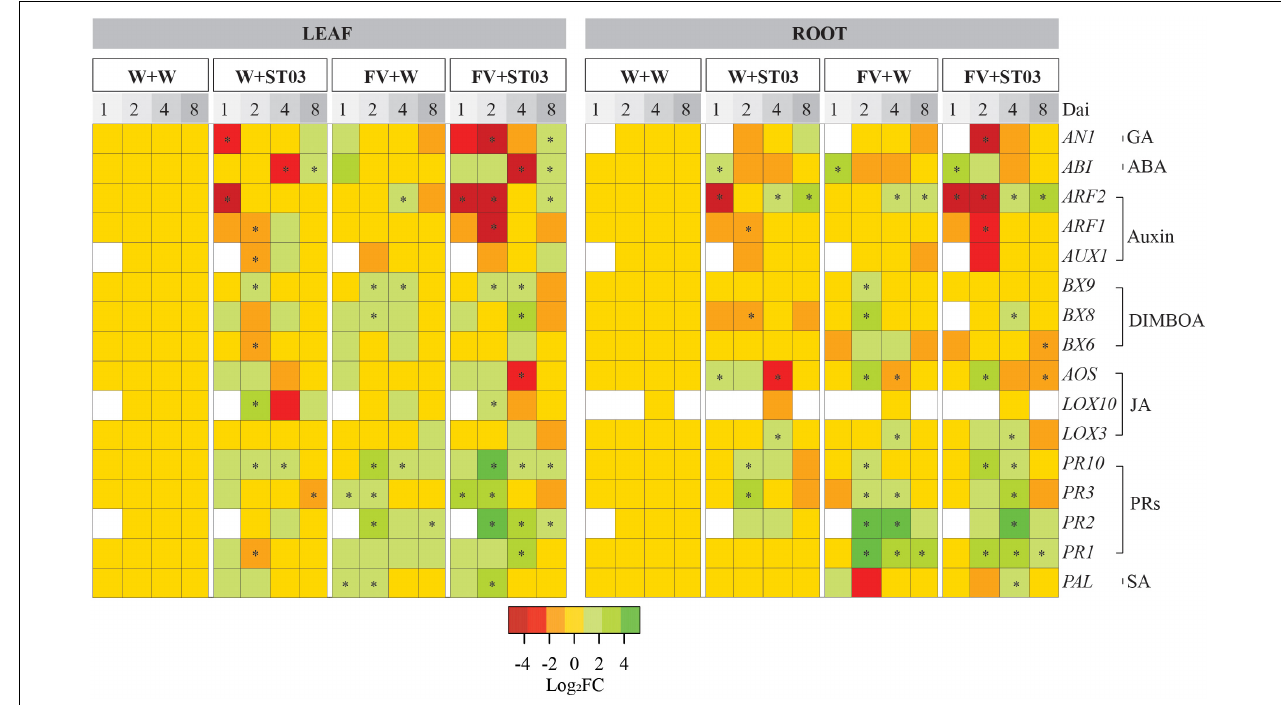
FIGURE 7 | Heat map of the differential gene expression levels in leaf and root by treatments at four-time points. This work applied Bt/GT NK7328-maize line. The colors indicate the FC changes (FC) of gene expression in log base 2. Up-regulation of each gene is shown in green (increased abundance), down-regulation is shown in red (decreased abundance), no change is shown in yellow, and absence of expression is indicated in white. Salicylic acid (SA); jasmonic acid (JA); 2,4-dihydroxy-7-methoxy-1,4-benzoxazin-3-one (DIMBOA); abscisic acid (ABA); gibberellic acid (GA); auxin/indole-3-acetic acid (Aux/IAA). dai, days after inoculation. Defense response was monitored at 1, 2, 4, and 8 dai. F. verticillioides -infected maize seeds were planted in soil pre-inoculated with the biocontrol strain ST03 (FV + ST03) and planted in mock-inoculated with sterile water soil (FV + W); F. verticillioides non-infected maize seeds were planted in soil pre-inoculated